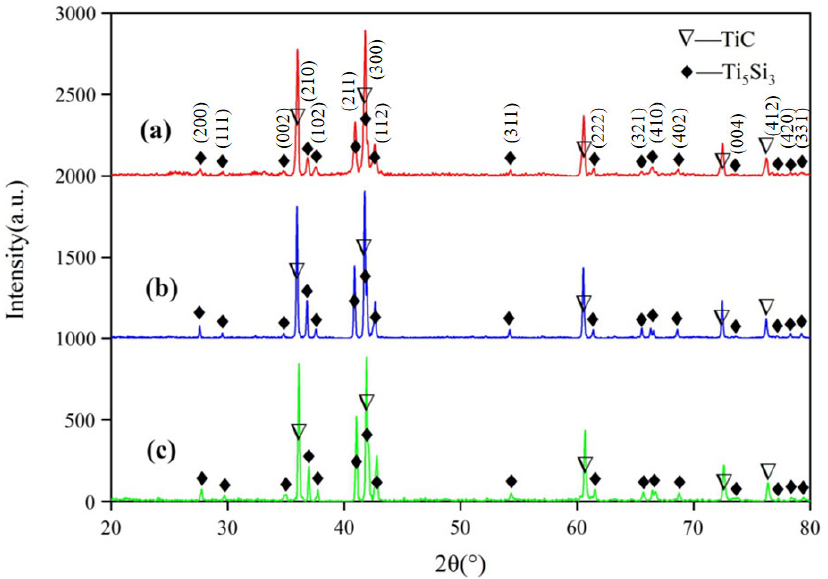
Figure 4. XRD patterns of the extracted powders from prepared composites. ( a ) Cu ‐ 4.86Ti ‐ 1Si ‐ 0.43C; ( b ) Cu ‐ 6.8Ti ‐ 1.4Si ‐ 0.6C; ( c ) Cu ‐ 9.72Ti ‐ 2Si ‐ 0.86C.